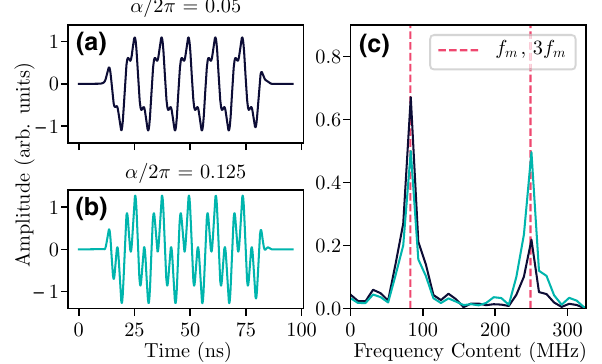
FIG. 1. (a),(b) Example waveforms described by Eq. (1). The pulses in (a) and (b) differ only in mixing angle α , sharing the following parameter values otherwise: p = 3, f m = 82.9 MHz, θ/ 2 π = 0.675. (c) The Fourier transform of the pulses in (a) and (b), showing content at f m and 3 f m with relative strengths depen- dent on α . For α/ 2 π = 0.125, displayed in teal, both tones are weighted